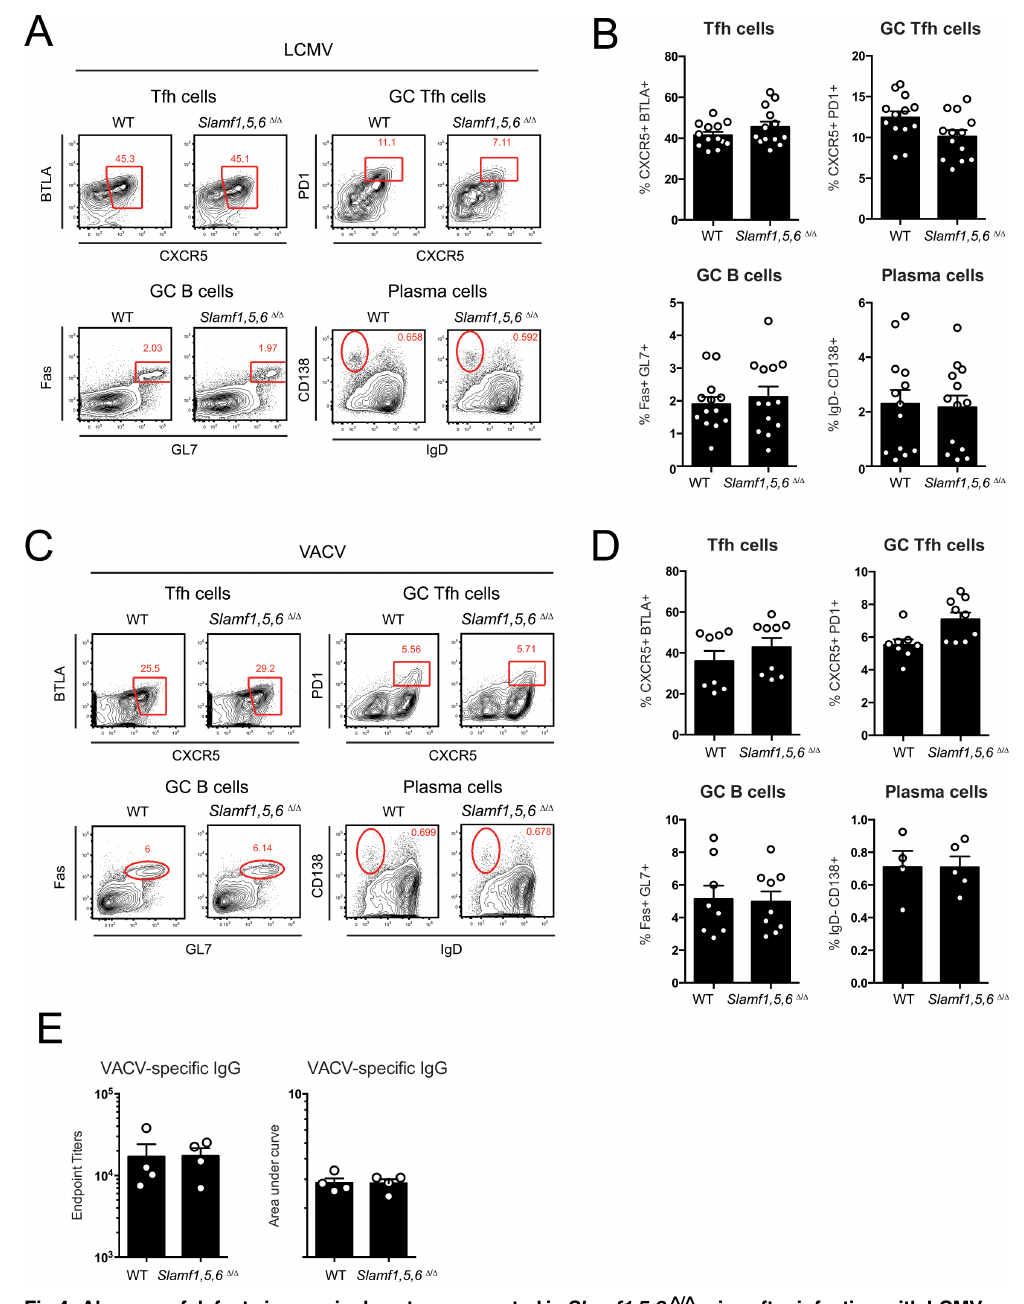
Fig 4. Absence of defects in germinal centers generated in Slamf1 , 5 , 6 Δ / Δ mice after infection with LCMV and VACV. (A) Flow cytometry plots and (B) graphs of CD19 - CD4 + CD44 + CXCR5 + BTLA + Tfh cells, CD19 - CD4 + CD44 + CXCR5 + PD1 + GC Tfh cells, CD4 - CD19 + Fas + GL7 + GC B cells, and CD4 - CD19 + IgD - CD138 + plasma cells in spleens of WT and Slamf1 , 5 , 6 Δ / Δ mice at 8 days post infection with LCMV. (A-B) Data represents three independent experiments, with 4 – 5 mice per group. (C) Flow cytometry plots and (D) graphs of CD19 - CD4 + CD44 + CXCR5 + BTLA + Tfh cells, CD19 - CD4 + CD44 + CXCR5 + PD1 + GC Tfh cells, CD4 - CD19 + Fas + GL7 + GC B cells, and CD4 - CD19 + IgD - CD138 + plasma cells in spleens of WT and Slamf1 , 5 , 6 Δ / Δ mice at 8 days post infection with VACV. (C-D) Data represents two independent experiments, with 4 mice per group. (E) Endpoint titers and Area Under Curve (AUC) analyses of VACV specific serum IgG at 15 days post infection with VACV. Data represents one experiment, with four mice per